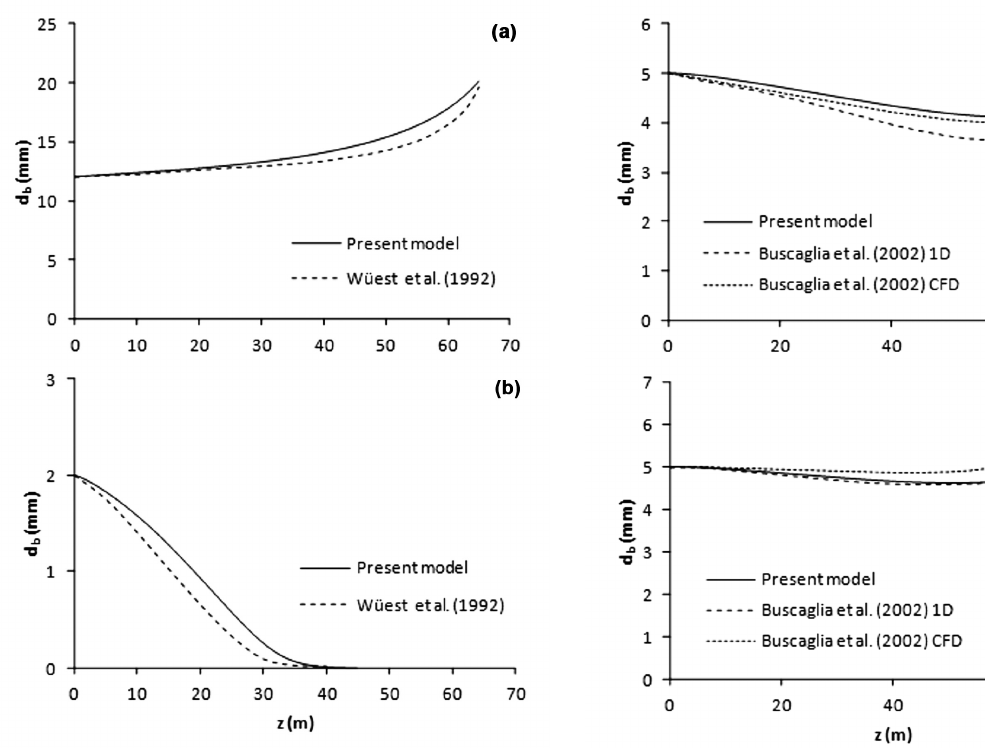
Figure 5 - Comparison between present model simulations and those from the integral model of Wüest et al. (1992): H m and (a) initial bubble diameter d m 3 /s (aeration); and (b) initial bubble diameter d Q = 0.0062 m 3 /s (oxygenation). g,a